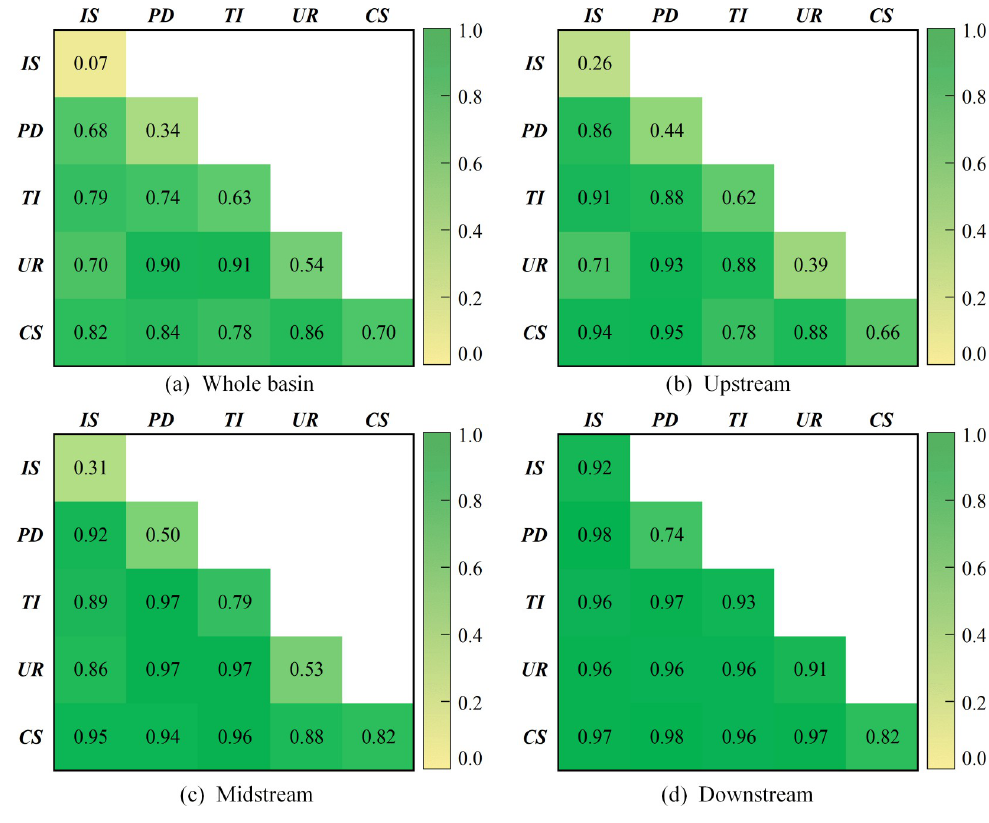
Fig 8. Detection results of the interaction of external